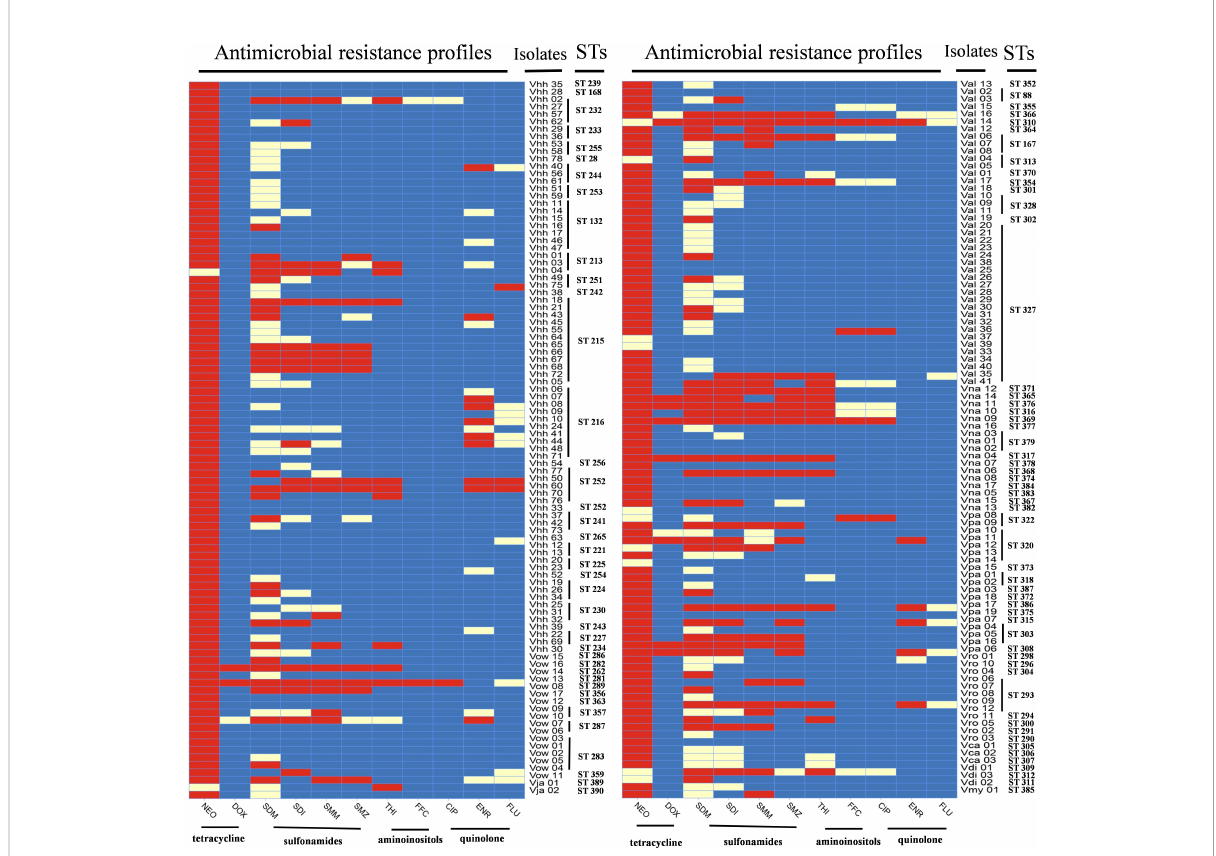
FIGURE 5 Levels of antibiotic resistance pro fi les of 11 tested antibiotics. The black bar, the gray bar, and the light gray bar represent the proportion of resistant strains, intermediate strains, and sensitive strains, respectively. The gray striped bar represents the proportion of the multiple antibiotic resistance index of the strains.